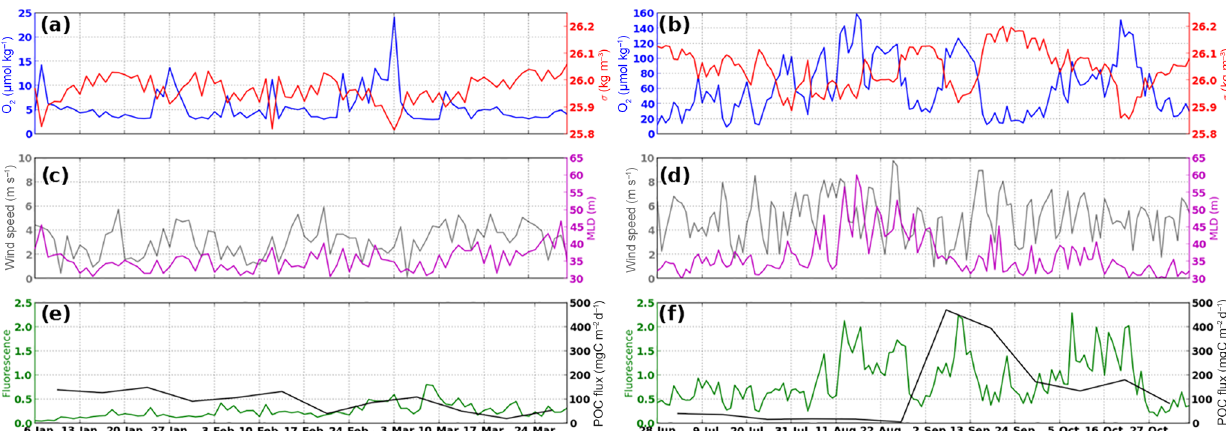
Figure 4. Time series documented at the mooring site in 2013 of oxygen concentration and density at the upper trap, of mixed-layer depth (MLD) and wind speed at the surface, and of POC flux and fluorescence at the upper trap, for each sample. Left and right pan- els are for AMOP summer (denoted AMOP1) and AMOP winter–spring (denoted AMOP2), respectively. (a–b) Daily oxygen concentration ( [ O 2 ] 1day_15min , blue line) and density (red line) calculated from pressure, temperature and salinity data acquired with the PTS sensors (see Fig. 1c) at 34m of depth. (c–d) Daily MLD (purple) and wind velocity (grey) from the ASCAT satellite. (e–f) Weekly POC flux at 34m (black) in mgCm − 2 d − 1 and daily fluorescence data at 31m (green) in relative units. For more details, see Sect.